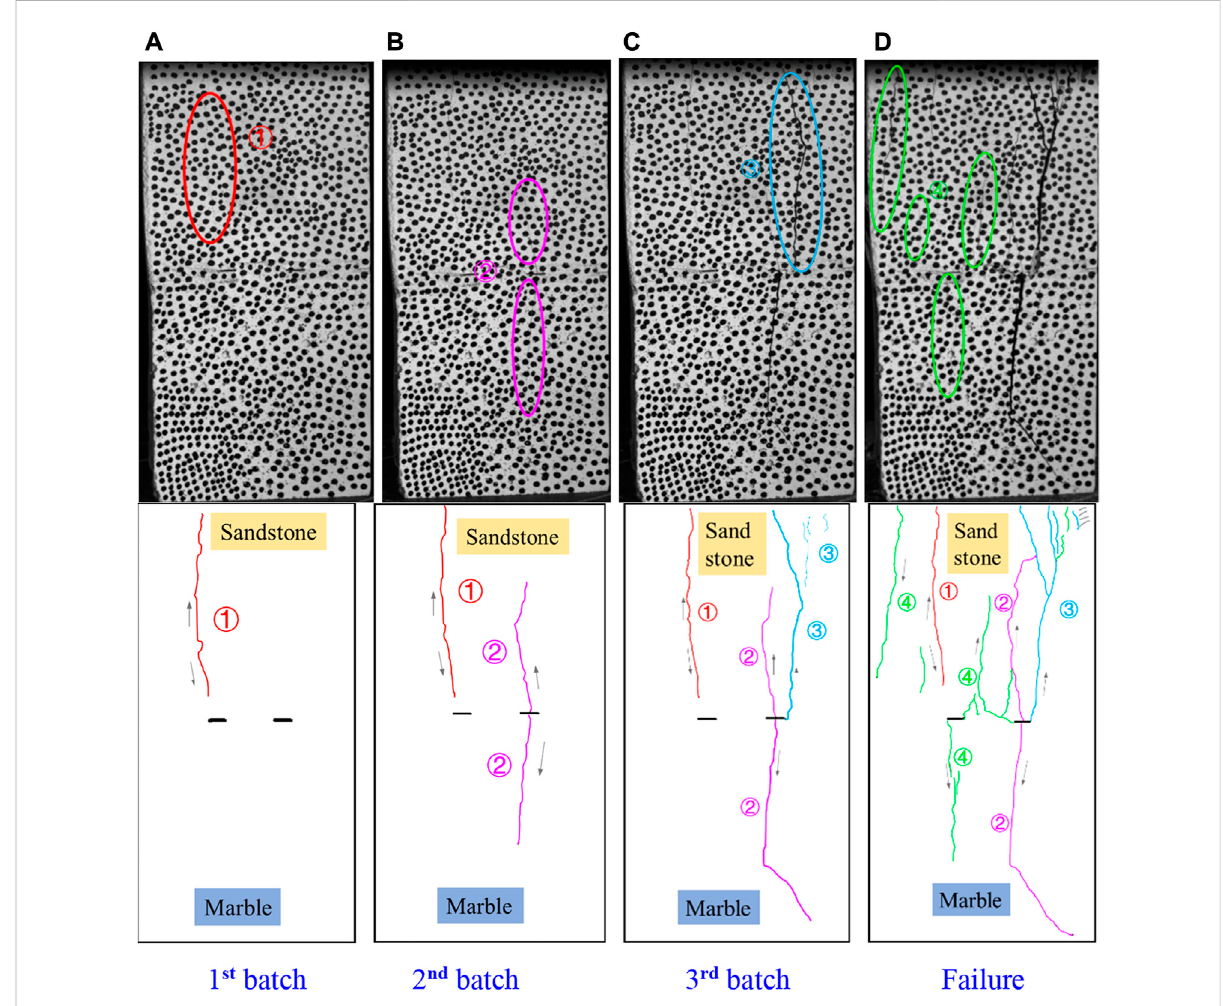
FIGURE 10 Propagation and distribution of surface cracks on specimen. ① , ② , ③ , and ④ represent the crack batches, and the arrow represents the direction of crack propagation. (A) 1st batch, (B) 2nd batch, (C) 3rd batch, (D)